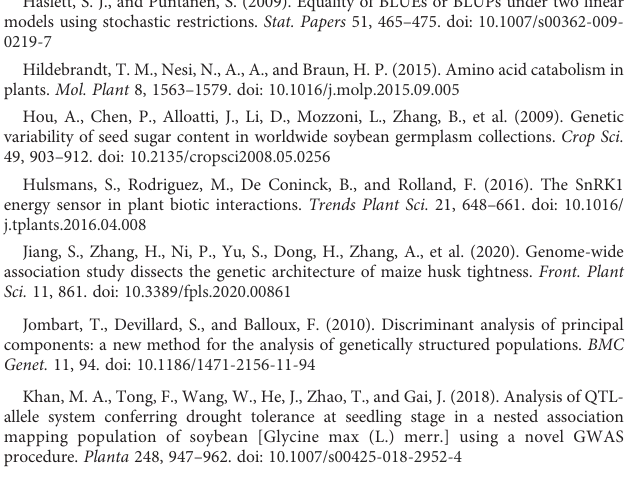
SUPPLEMENTARY FIGURE 1 SNP associations for edamame sucrose content from (A) BLUE combined dataset, (B) Blacksburg, VA, combined, (C) Portageville, MO, combined, (D) Fayetteville, AR, combined, aredisplayed in Manhattan plots with chromosomes in alternating colors, signi fi cance thresholds-log10(P) > 3.01 (the blue line) and suggestive threshold-log10(P) > 2.70 (the red line). Each respective QQ plot displays observed-log10(P) against expected-log10(P). SUPPLEMENTARY FIGURE 2